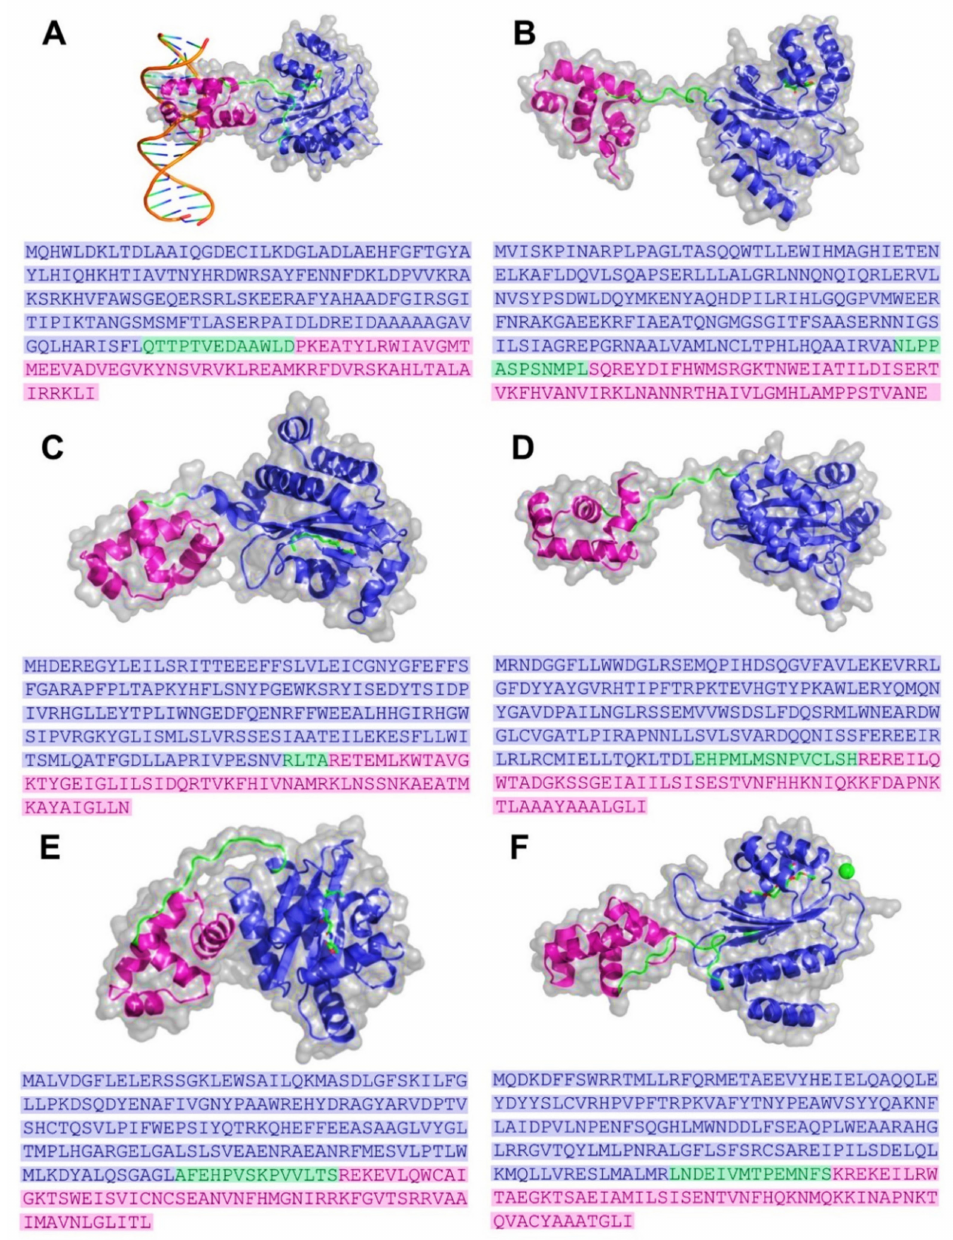
Figure 5. Structure of AHL regulators. Cartoon representation showing the ligand-binding domain (slate), domain-connecting loop (green), and the DNA-binding domain (DBD) of bacterial AHL regulators. The lower panel shows the FASTA sequence of the protein, highlighting the residues of the corresponding regions: ( A ) TraR, ( B ) CviR, ( C ) QscR, ( D ) RhlR, ( E ) LasR, and ( F )